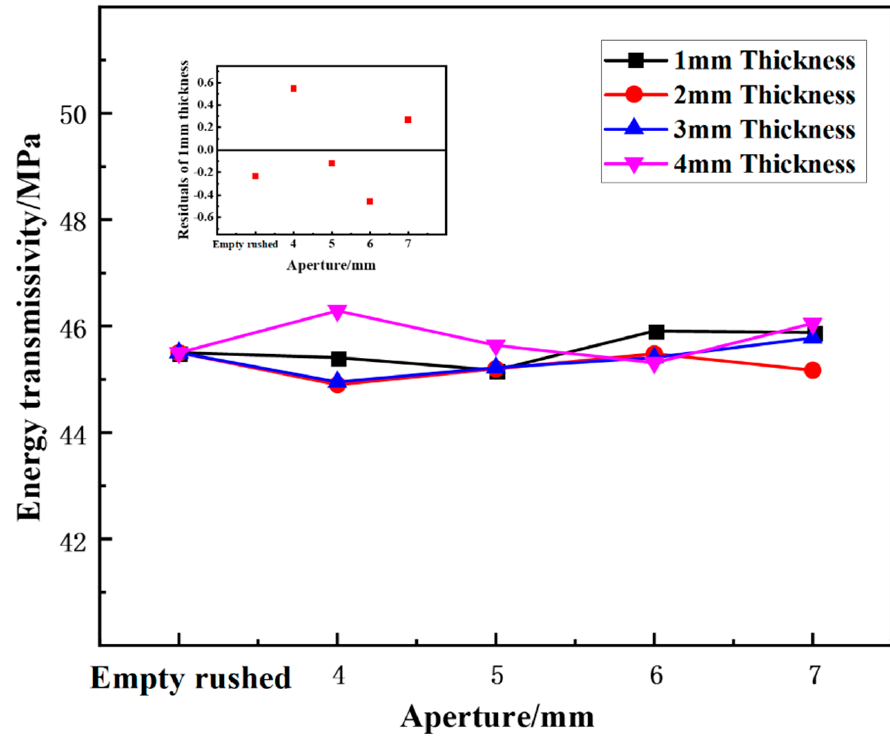
Figure 10. Variation trend of energy transmittance of wave-absorbing metal plate with aperture.